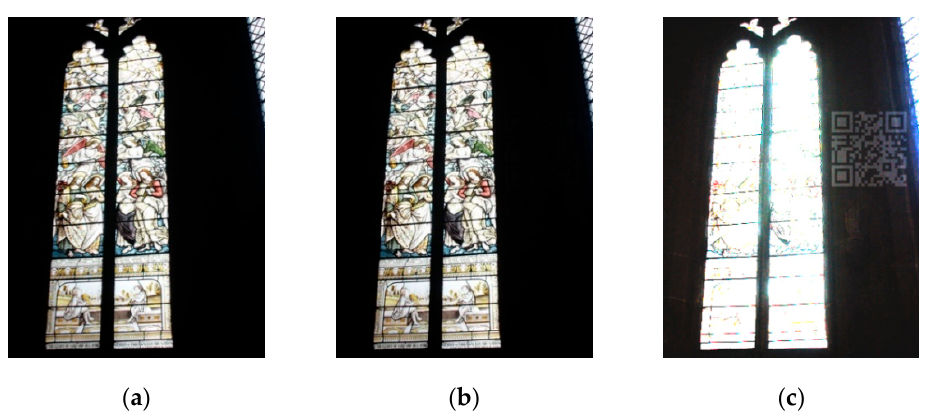
Figure 10. Sample set of images with QR code exhibited by the GCF = 0.2, ( a ) original image, ( b ) watermarked image with PSNR = 50.16 dB, SSIM = 0.9919, NCD = 0.279, ( c ) exhibited watermark.